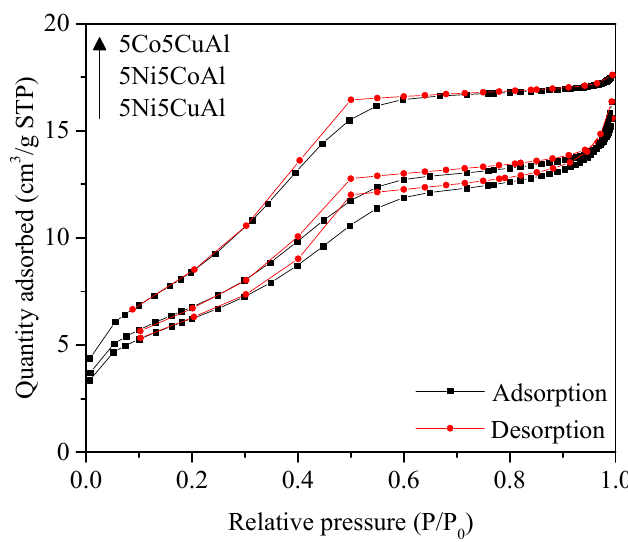
Figure 2. N 2 adsorption–desorption isotherms of the 5M5MAl catalyst samples. Table 1. X-ray fluorescence (XRF) elemental analysis and textural properties of the 5M5MAl catalyst samples.